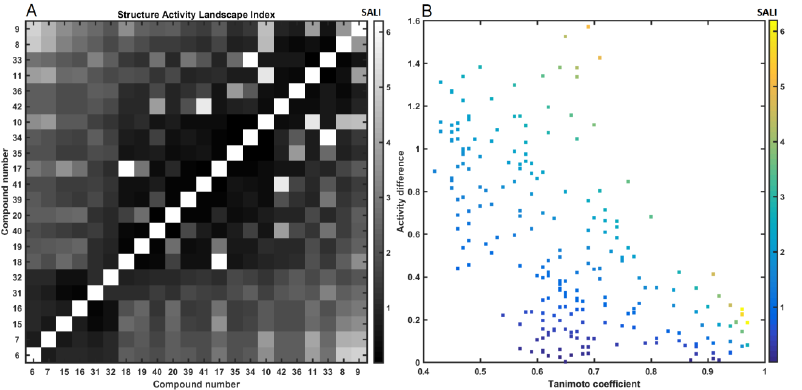
Figure 13. Grayscaled SALI plot with compounds ordered by increasing pIC 50 values ( A ) and neighboring plot for carborane-based molecules ( B ).